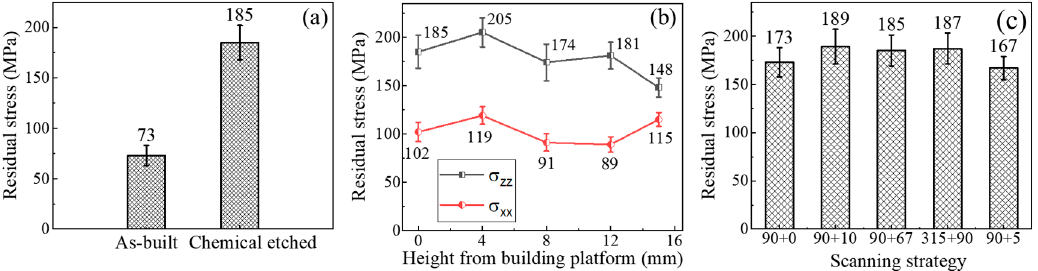
Figure 4. Residual stresses measured using XRD ( a ) at the same position of the same sample before and after surface treatment; ( b ) on lateral surface of the chemical etched sample; ( c ) on samples fabricated with five different scan strategies. Positive values represent tensile residual stresses.